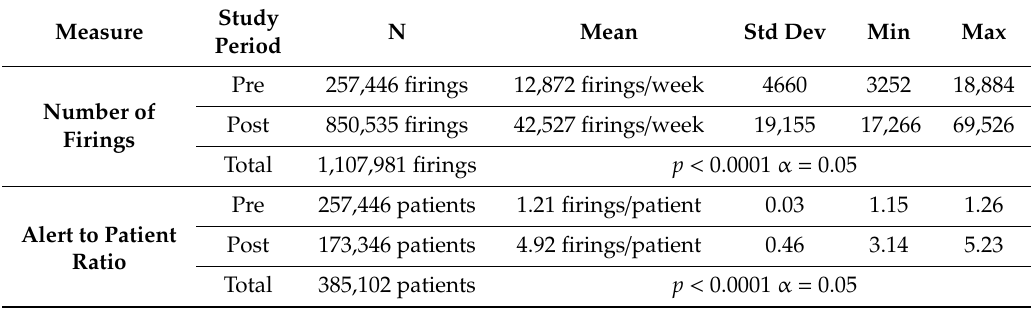
Table 2. Alert Fatigue Pre- and Post-Storyboard Implementation.